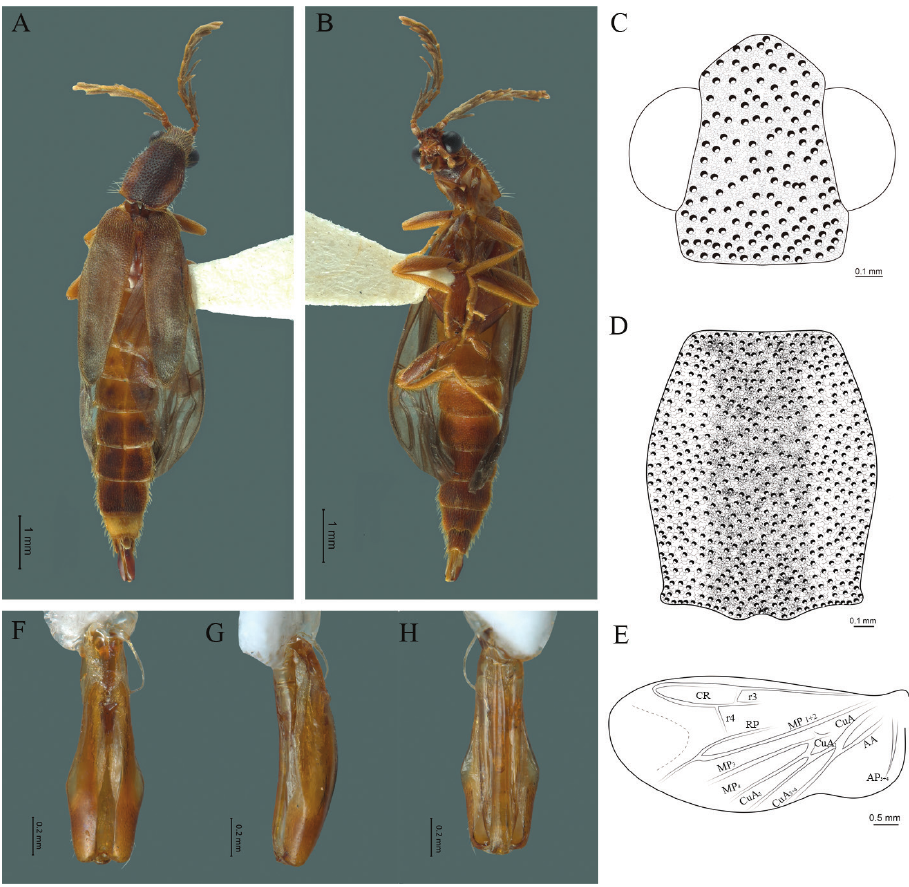
Figure 31. Cenophengus wittmeri Zaragoza-Caballero, 1984, male. Habitus: A dorsal B ventral C head dorsal D pronotum E hind wing. Wing venation: CR = Radial Cell; r3 = radial 3 vein; r4 = radial 4 vein; RP = Posterior Radial vein; MP1+2 = Posterior Median vein; CuA = Cubital vein; AA and AP = Anterior and Posterior Anal veins. Aedeagus: F dorsal view G lateral view H ventral length of pronotum, antennal rami twice as long as the respective antennomere and each elytron 3.7 times as long as wide; aedeagus with three teeth at the inner apex of paramere. Redescription. Male. Body length 5.80–9.20 mm, maximum body width 0.87– 1.04 mm (pronotum). Body brown, except for middle part of pronotum and last two sternites dark brown, elytral apex whitish (Fig. 31A, B). Head . Wider (0.83–0.90 mm) (0.85 ± 0.034 mm, n = 4) than long (0.62–0.80 mm) (0.74 ± 0.081 mm, n = 4) (Fig. 31C), at eye level, almost as wide as the pronotum, integument chagreened with punctures twice as large as eye facets and separated by approximately 2 punc- tured diameters, each puncture bearing a yellow-brown seta; interantennal distance (0.09–0.11 mm) (0.1 ± 0.009 mm, n = 4) less than the length of antennomere 1 (0.22–0.28 mm) (0.25 ± 0.0.21 mm, n = 4); eyes 1/2 as long as head in lateral view,